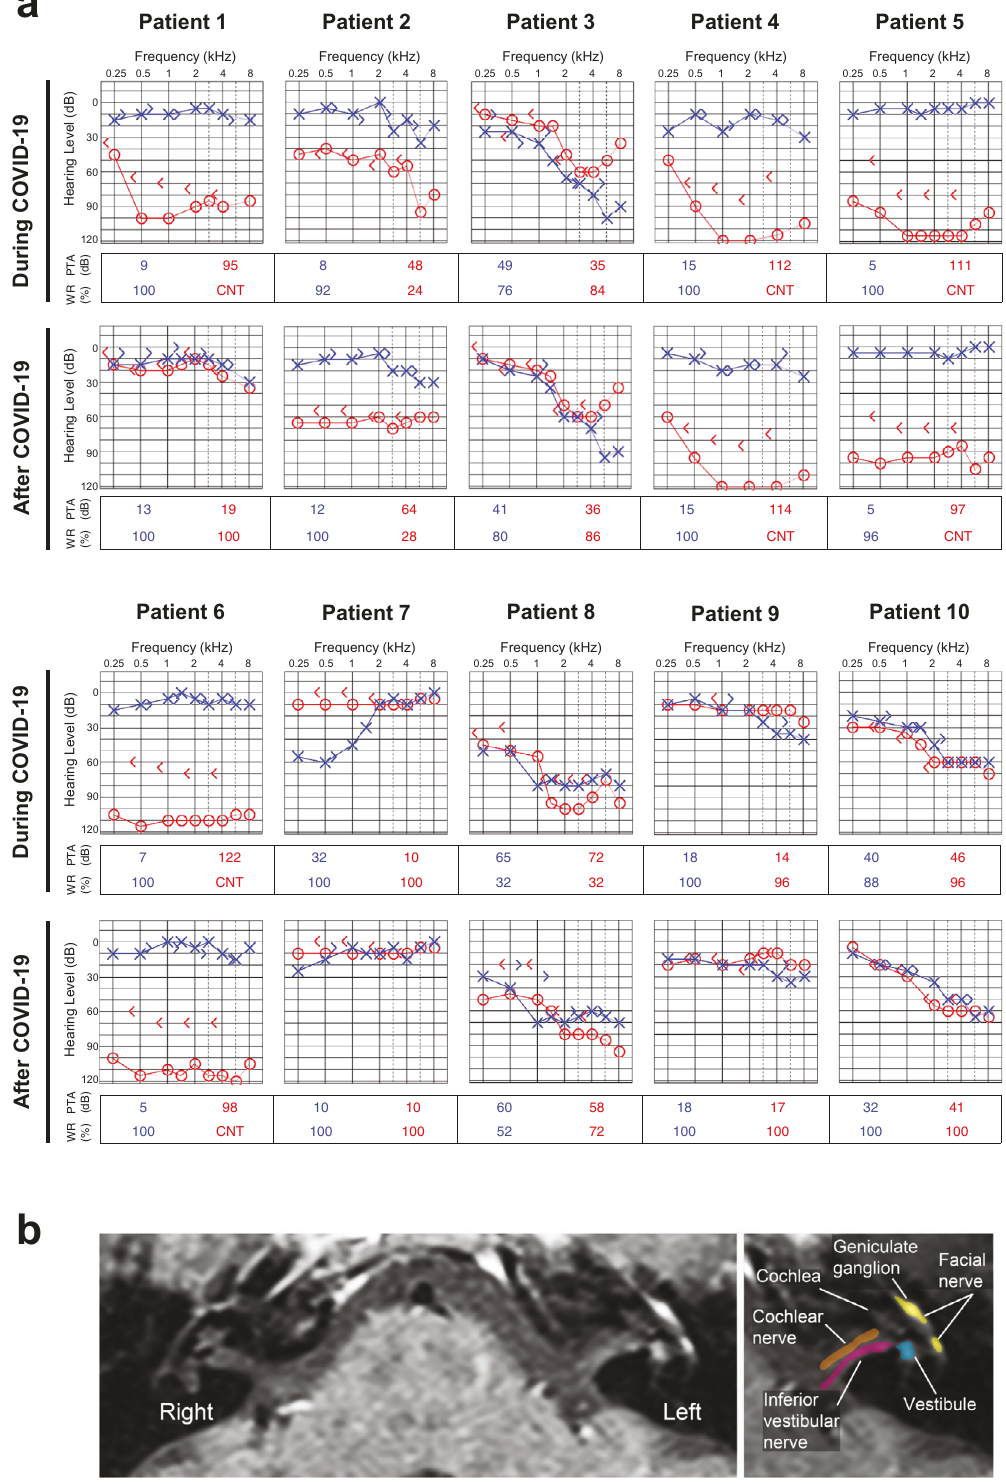
SARS-CoV-2 infection in OPCs . Having established that OPCs cell surface (Fig. 3d). In contrast, in OPCs, ACE2 and FURIN were found in the cytoplasm and cell surface (Fig. 3d). The dis- and SCPs express SARS-CoV-2 entry-related genes, we next tribution of ACE2 and FURIN in SCPs more closely resembled infected the OPCs and SCPs with SARS-CoV-2. Addition of that in hiPSCs, with considerably less cytoplasmic/cell-surface SARS-CoV-2 at a MOI of 1 to OPCs derived from hiPSC line expression of ACE2 and FURIN in these cells compared to OPCs UCSD112i-2-11 resulted in an infection rate of 26.01 ± 4.94% (Fig. 3d). Finally, TMPRSS2 was detected in the cytoplasm in (mean ± SD) at 48 hpi as measured by percent of cells expressing both OPCs and SCPs. viral NP (Fig. 4a). Infection rates were not dramatically increased COMMUNICATIONS MEDICINE| (2021) 1:44